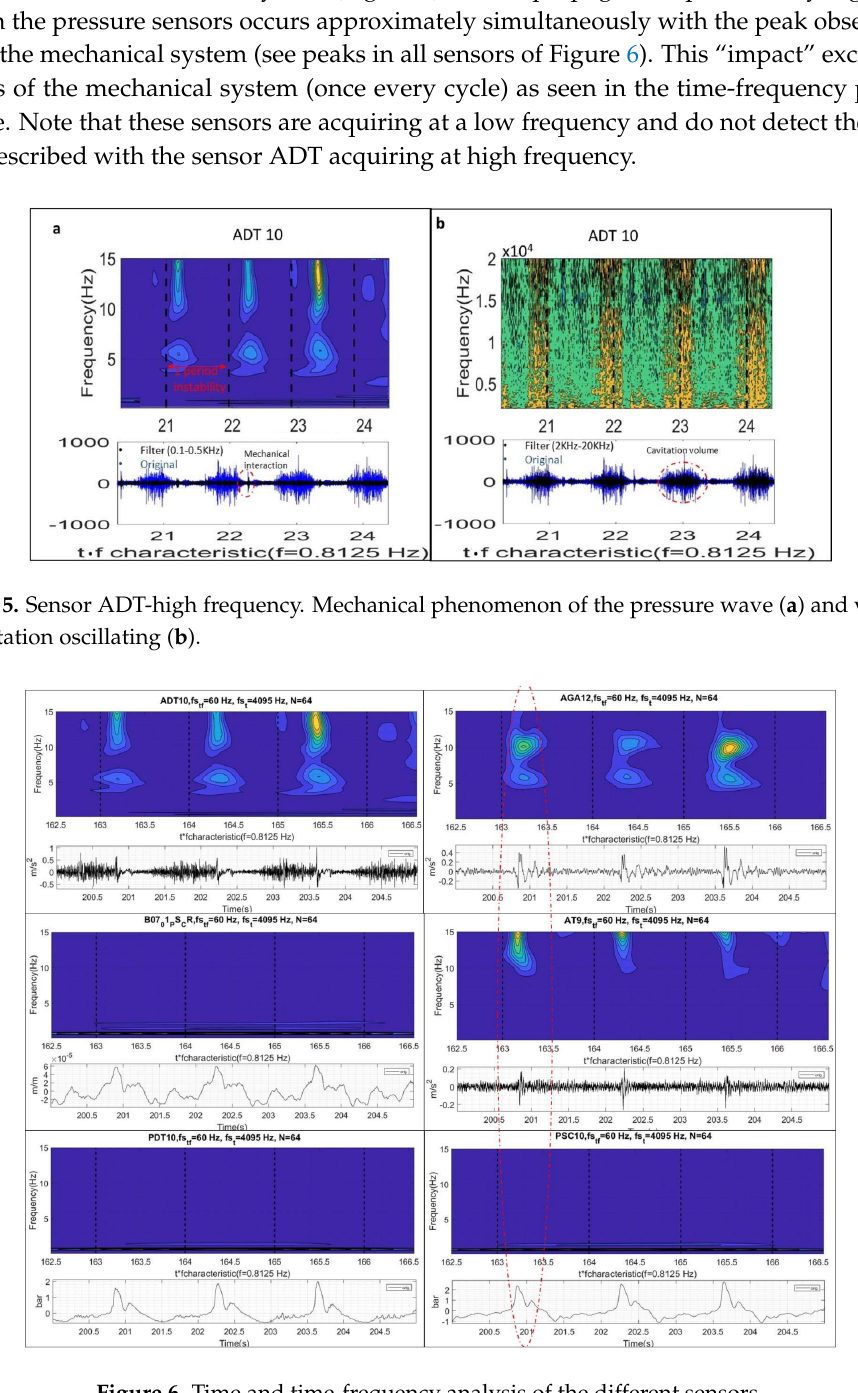
Figure 6. Time and time-frequency analysis of the different